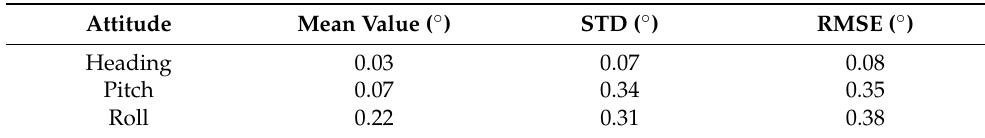
Table 4. Results of the comparison tests in standing conditions expressed in terms of differences between the measured and reference angles.